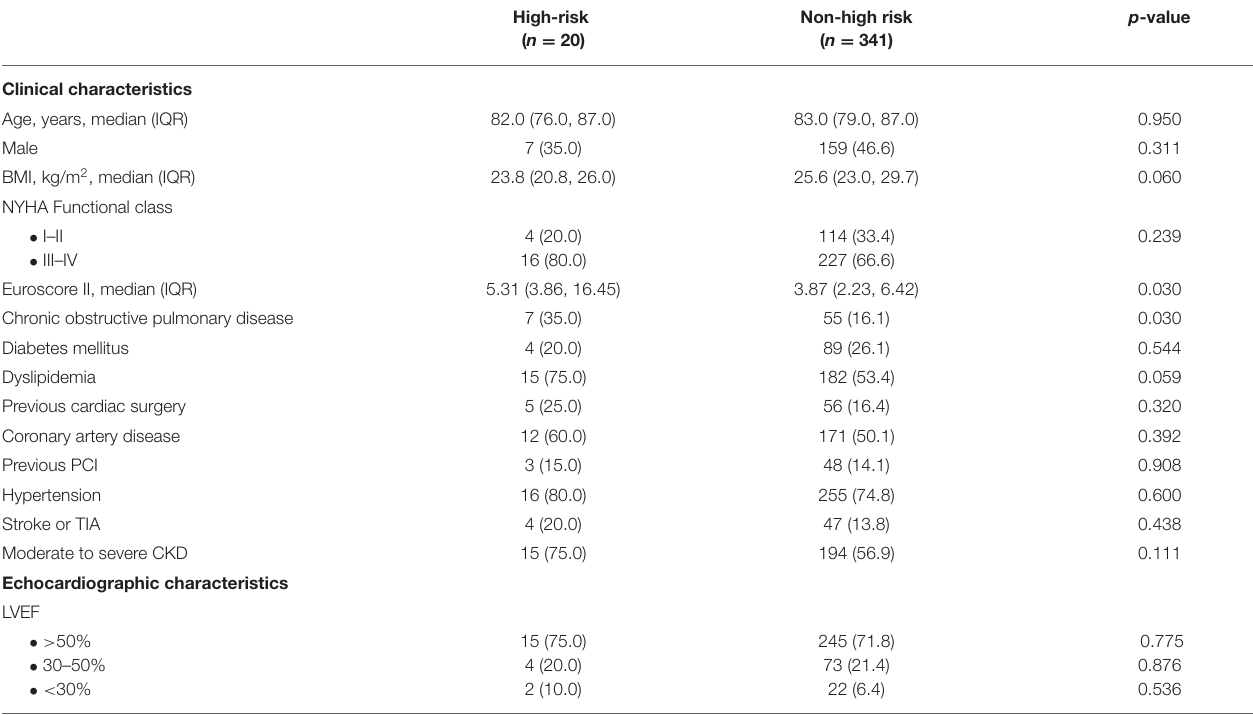
TABLE 3 | Baseline clinical and echocardiographic characteristics of patients at high-risk for mesenteric ischemia, vs. patients non at high-risk.